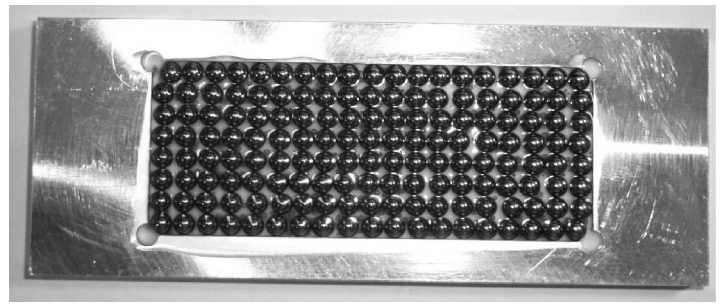
Fig. 59. EIDL Embedded in an Aluminium